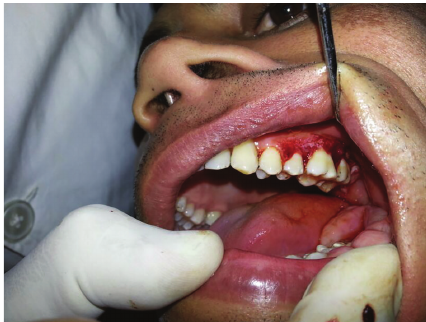
Figure 5: Operative (maxillary).